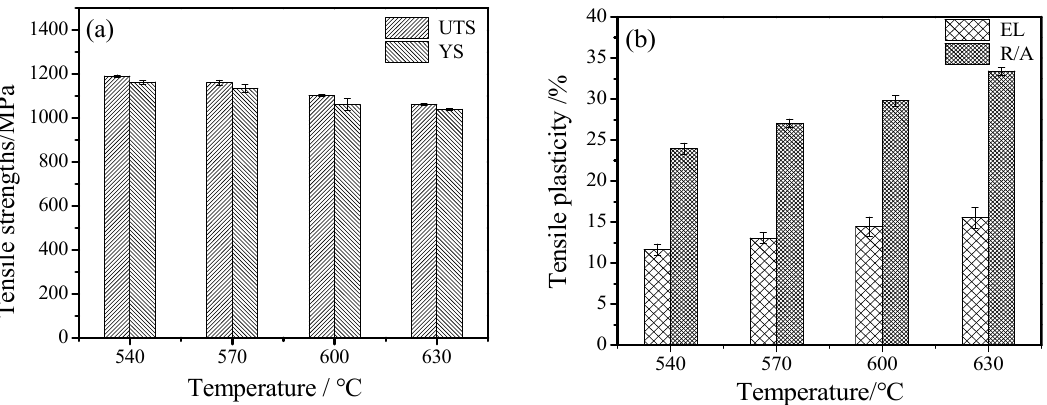
Figure 6. Tensile properties of Ti ‐ 17 alloy at different aging temperature: ( a ) tensile strength and yield strength; ( b ) elongation and reduction of area.